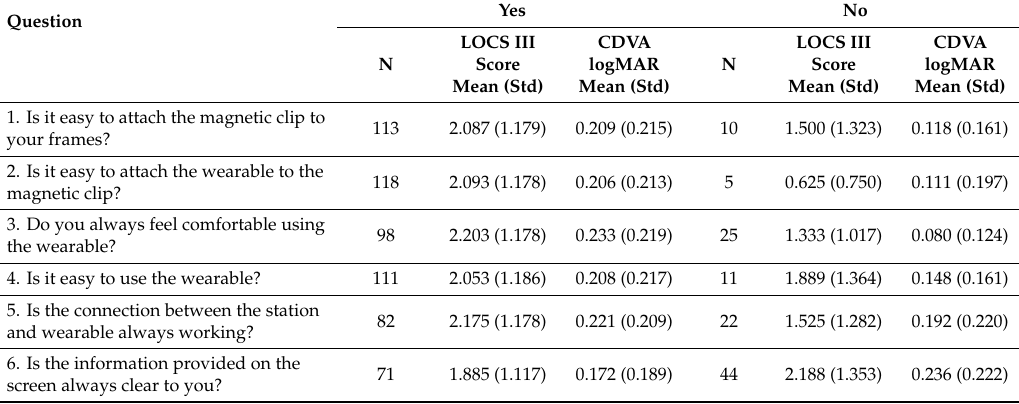
Table 2. Distribution of the preoperative corrected distance visual acuity and Lens Opacities Classification System (LOCS) III score of the patients separated by the answers in the usability questionnaire.